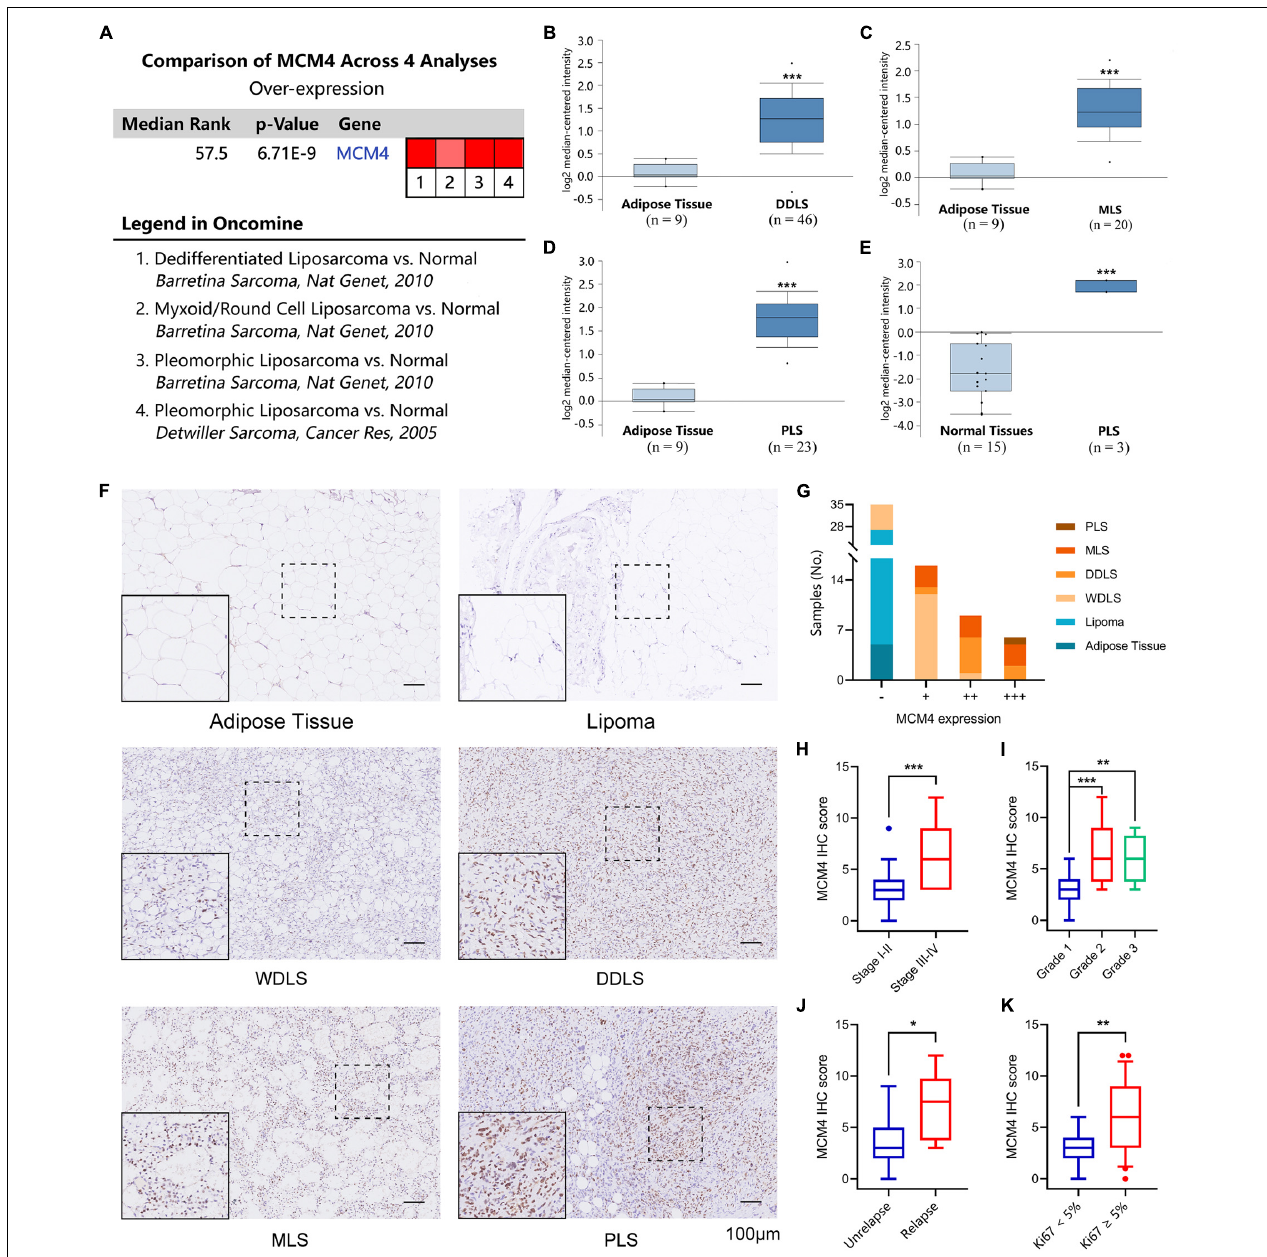
FIGURE 3 | Validation of MCM4 as a biomarker of LPS by Oncomine database and archived surgical specimens. A total of four registries supporting the high tumoral expression of MCM4 vs. normal, while no studies supported the MCM4-high expression in normal tissues (A) . MCM4 was found to be consistently overexpressed in dedifferentiated LPS (DDLS) (B) , Myoxoid LPS (MLS) (C) , and Pleomorphic LPS (PLS) (D,E) compared to the adipose control. Using 66 archived surgical specimens, we confirmed the overexpression of MCM4 in LPS, but not the adipose tissue or benign lipoma (F,G) . MCM4 Immunohistochemistry (IHC) scores significantly correlated with AJCC stage, histological grade, tumor relapse-free survival, and Ki67 index ( t -test, p < 0.05) (H–K) . * p < 0.05, ** p < 0.01, ** p < 0.001,scale bar = 100